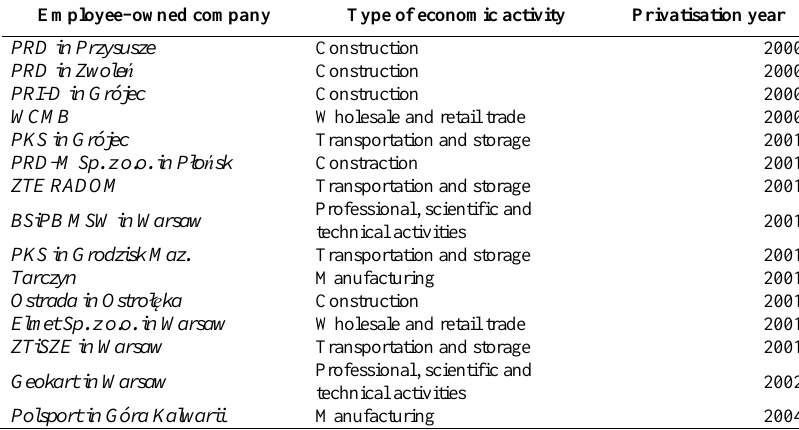
Table 1. Employee–owned companies qualified for the research sample